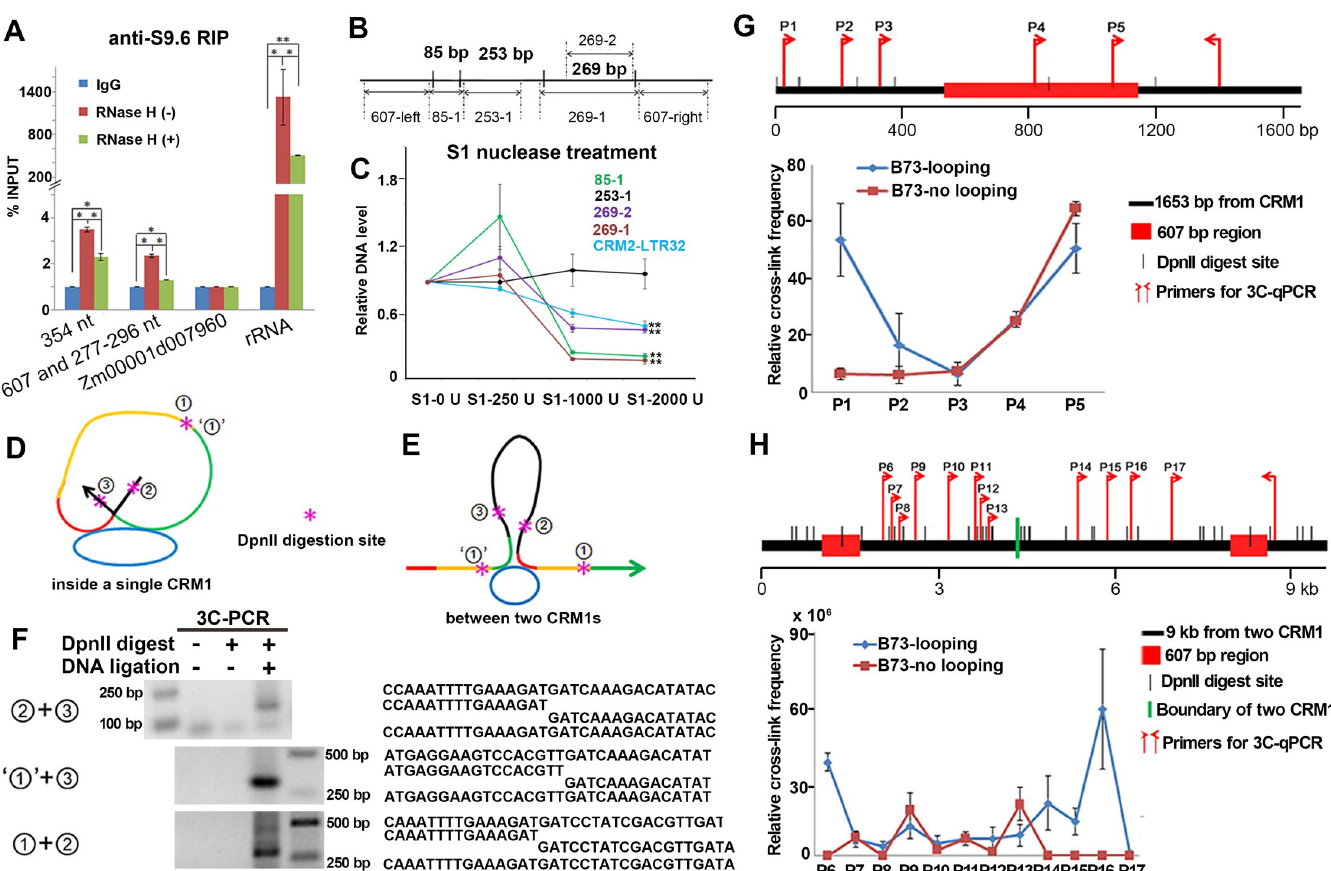
Fig 3. Circular CRM1 RNAs induce chromatin loops in the centromere. (A) Anti-S9.6 RIP-qPCR was used to confirm the R-loop formation by 354-, 607-, and 277- to 296-nt circular CRM1 RNAs. Zm00001d007960 RNA was used as a negative control, and rRNA was used as a positive control. Chromatin-binding RNA was used for RIP. Actin was used as an internal reference gene. (B) Regions chosen for detecting the ssDNA sites are marked as 85–1, 253–1, 269–1, and 269–2. (C) ssDNA sites in CRM1 were checked using an S1 nuclease treatment of the nuclear DNA. DNA with no S1 nuclease treatment was used as a control template. The 607-left sequence was used as an internal reference gene. (D and E) Potential chromatin loops were induced by circular RNA inside a single CRM1 element (D) and between two CRM1 elements (E). Red, green, and yellow lines represent the 85-, 269-, and 253-bp regions, respectively. Black lines represent sequences on the left side of the 85-bp sequence and the right side of the 269-bp sequence. The blue ovals represent circular CRM1 RNAs. ① , ‘ ① ’, ② , and ③ represent the broken ends on the two sides of the 253-bp sequence, the left side of the 85-bp sequence, and the right side of the 269-bp sequence. (F) 3C-PCR confirms the potential ligations of chromatin loops after DpnII digestion. The left panel shows the PCR results in the undigested, unligated samples and 3C samples under potential ligation forms. The right panel shows the sequences from the bands on the left, including the expected sequences, the first and the second part of the expected sequences, and the amplified sequences. (G and H) 3C-qPCR shows chromatin interactions inside a single CRM1 element (G) and between two CRM1 elements (H). The interaction frequencies between two DpnII -digested fragments were normalized to the 3C control template from the digested and ligated centromeric BAC clone and an internal reference gene, SAM . In (A), (C), (G), and (H), the columns and error bars represent the relative value and standard error of the means ( n = 3). In (A) and (C), the P values were determined using a Student t test: � P < 0.05, �� P < 0.01. The data underlying this figure can be found in S1 Data and S1 Raw Images. 3C, chromatin conformation capture; BAC, bacterial artificial chromosome; CRM, centromeric retrotransposon; IgG, Immunoglobulin G; nt, nucleotides; qPCR, quantitative PCR; RIP, RNA immunoprecipitation; ssDNA, single- strand DNA.